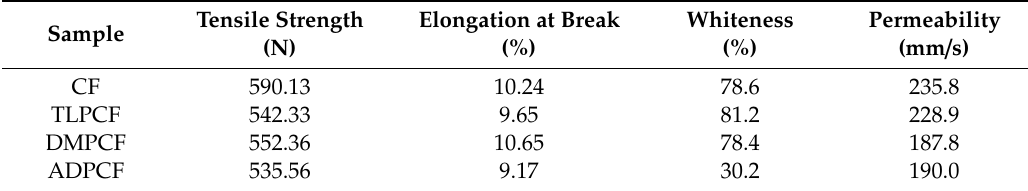
Table 3. Tensile strength, elongation at break, whiteness, and permeability of control and modified cotton fabrics.